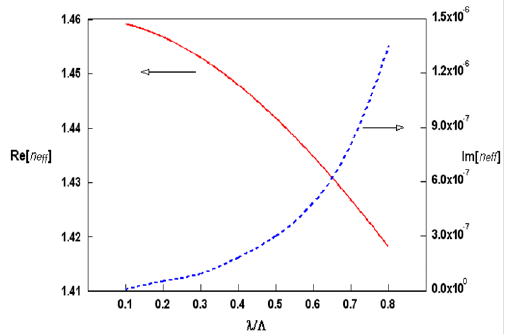
Figure 6. Wavelength responses of the real part (solid line) and the imaginary part (dashed line) of n eff for a 2 ring, 18 air-hole PCF when n silica = 1.46 and d/Λ = 0.6.